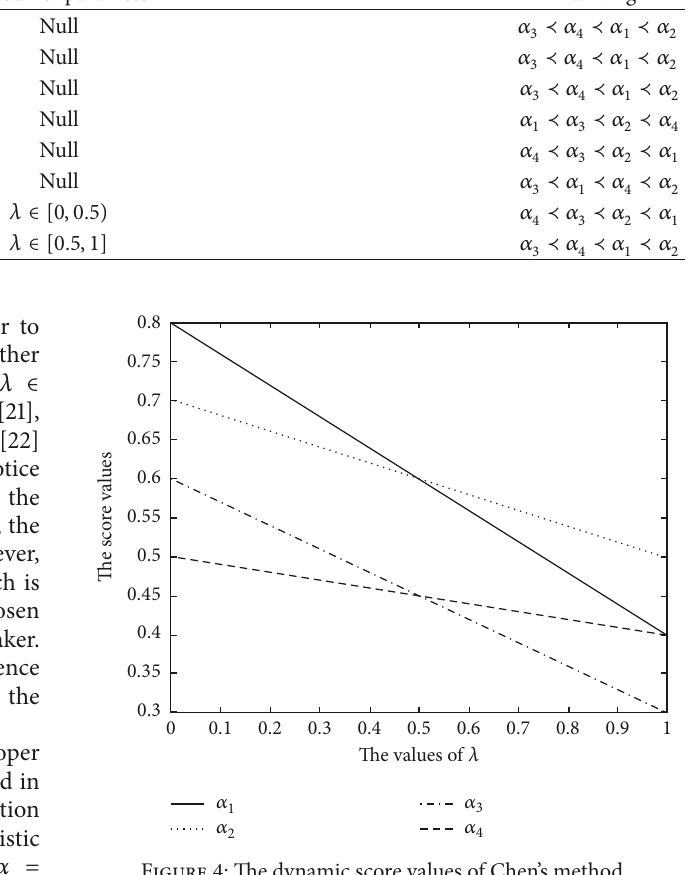
Figure 4: The dynamic score values of Chen’s